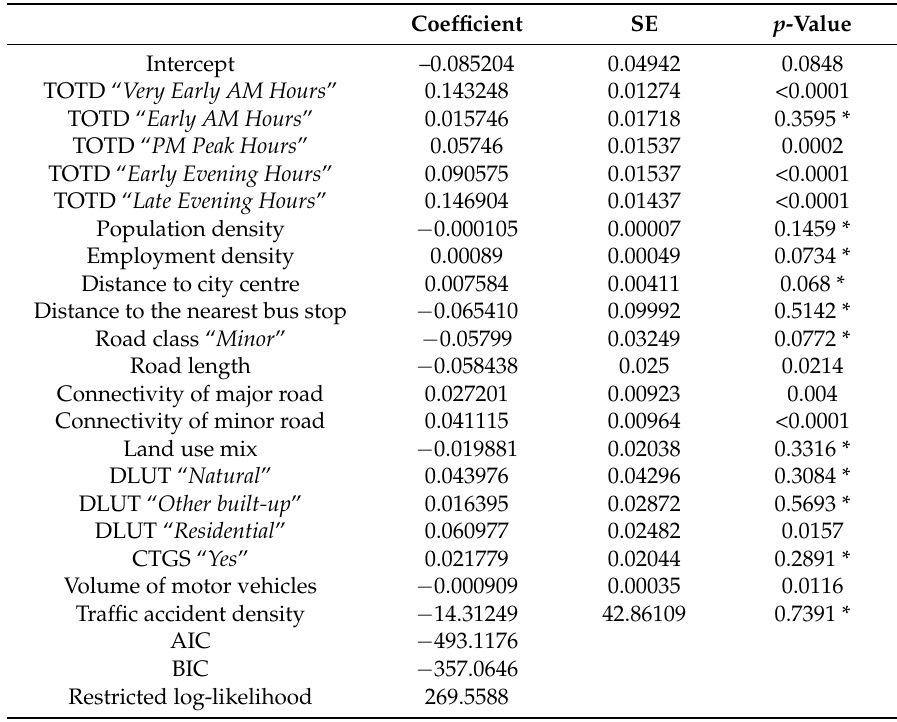
Table 4. The estimated linear mixed-effects model for